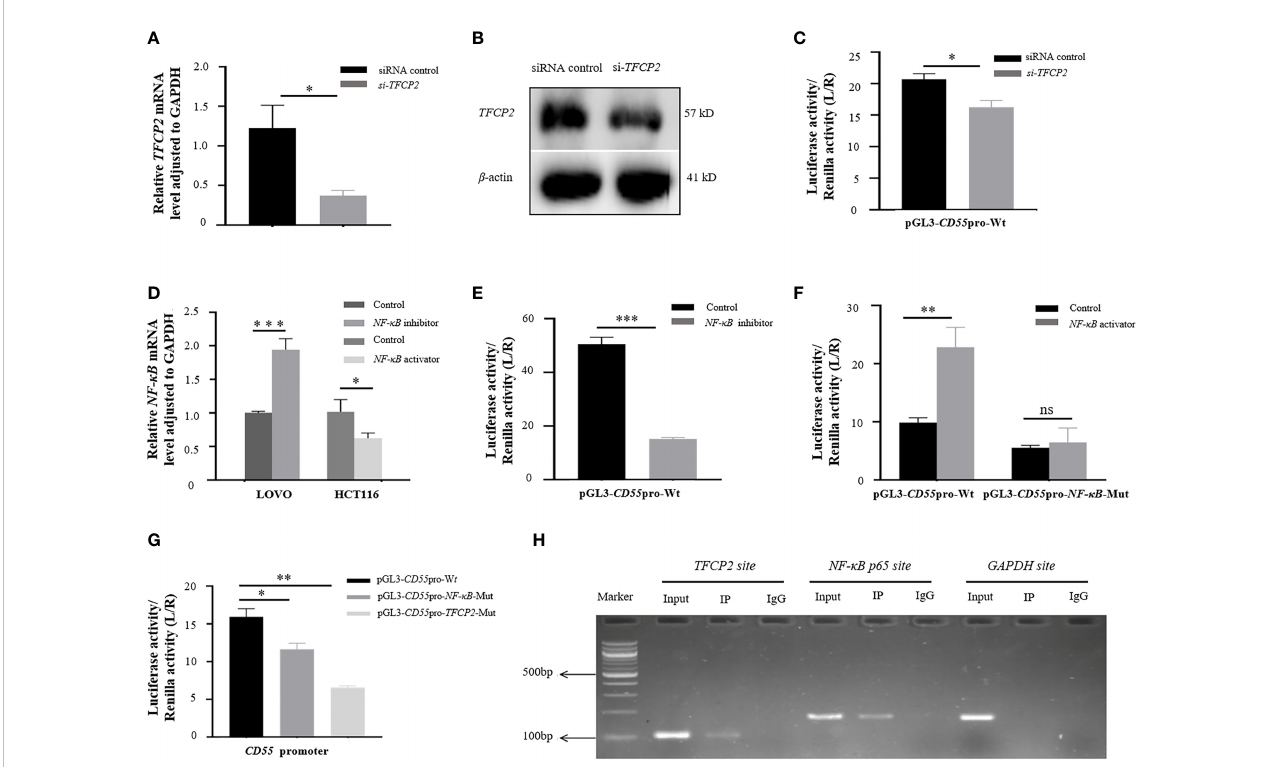
FIGURE 3 The regulation of transcription factors to the promoter of CD55 . (A) The mRNA level of TFCP2 by RT-PCR after HCT116 cells transfected with si- TFCP2 or siRNA control for 24 h. (B) The protein expression of TFCP2 by Western blotting after HCT116 cells transfected with si- TFCP2 or siRNA control for 48 h. (C) Dual-luciferase assay of pGL3- CD55 pro -Wt in HCT116 cells after co-transfected with si- TFCP2. (D) The mRNA level of NF- k B in HCT116 cells treated with NF- k B inhibitor and that in LOVO cells treated with NF- k B activator for 24 h. (E) The luciferase activity of pGL3- CD55 pro -Wt in HCT116 cells treated with or without NF- k B inhibitor. (F) The luciferase activity of pGL3- CD55 pro -Wt and pGL3- CD55 pro - NF- k B -Mut in LOVO cells treated with or without NF- k B activator (TNF a ). (G) CD55 promoter activity assay in pGL3- CD55 pro -Wt, pGL3- CD55 pro - NF- k B -Mut, and pGL3- CD55 pro - TFCP2 -Mut plasmids. Luciferase activity was normalized to Renilla luciferase activity (L/R). (H) The binding of TFCP2 and NF- k B to the promoter of CD55 by ChIP. IgG from rabbits served as a control (* p < 0.05, ** p < 0.01, *** p < 0.001, ns, no signi fi cance). ChIP, chromatin